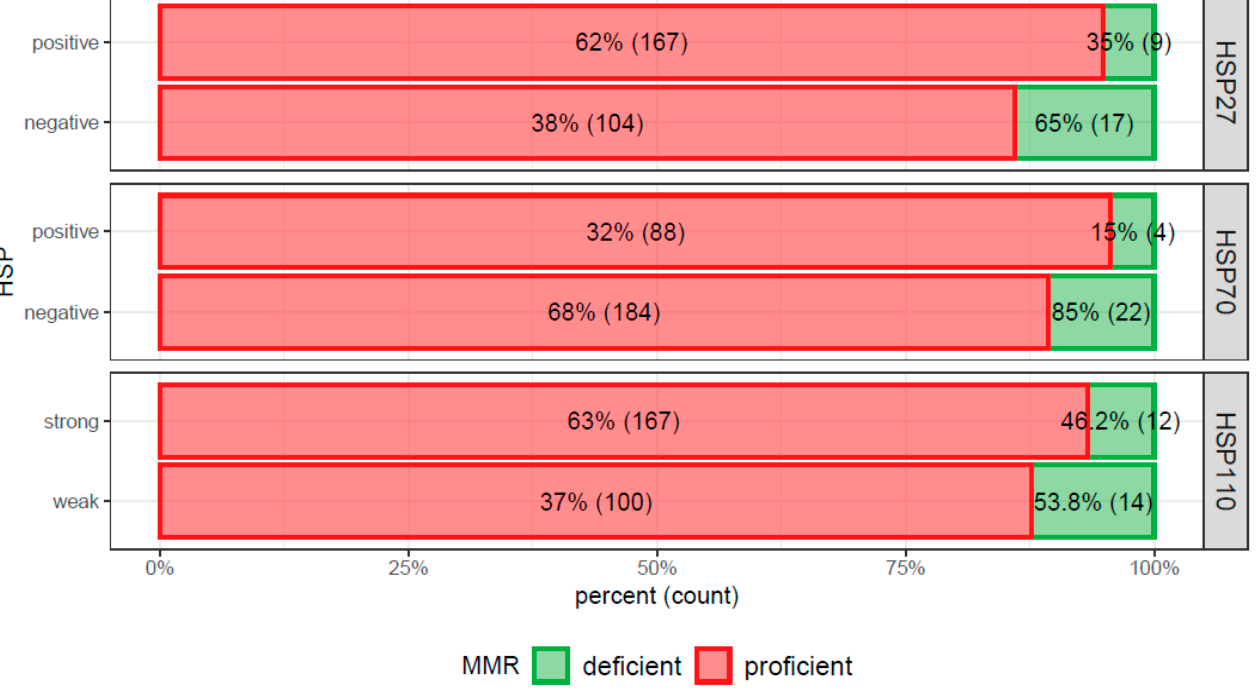
Figure 5. Bar chart documenting the Pearson’s chi squared test showing enrichment of mismatch-repair (MMR) proficient carcinomas with expression of heat shock proteins (HSPs)27 ( p = 0.014), 70 ( p = 0.117), and 110 ( p = 0.153) whereas only HSP27 showed a significant result.